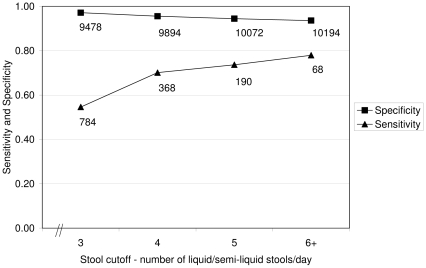
Sensitivity and specificity using different cutoffs for number of liquid/semi-liquid stools to define diarrhea.The sensitivity and specificity of caregiver diagnoses are shown for different cutoffs of reported frequency of liquid or semi-liquid stools. Caregiver diagnostic sensitivity increased from 0.55 using the cutoff of 3 stools per day to 0.78 when ≥6 stools were reported. Specificity was consistently >0.93.